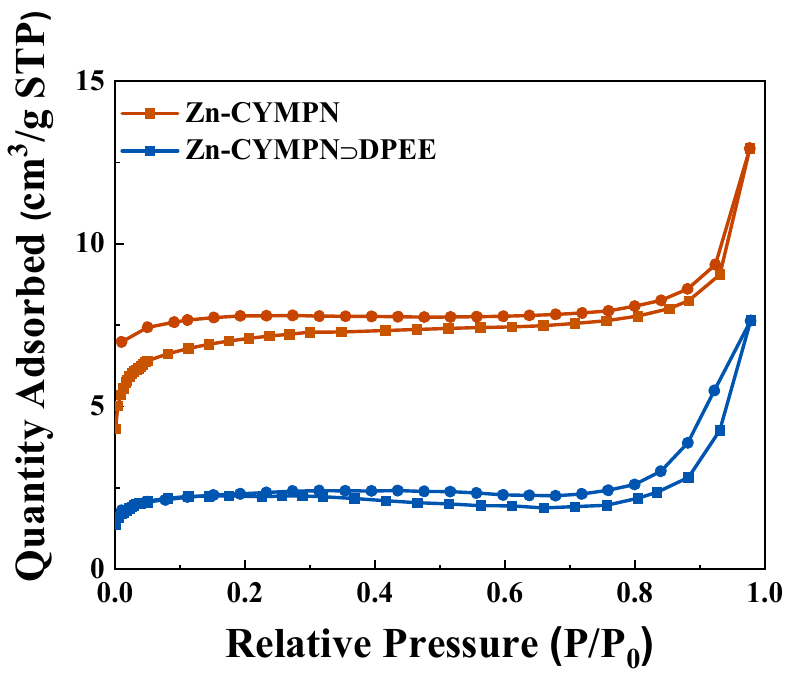
Figure 2. The N 2 adsorption/desorption isotherms of Zn-CYMPN and Zn-CYMPN ⊃ DPEE. Square symbols: adsorption; circular symbols: desorption. Table 1. The name, loading density and quantum yield of the samples.